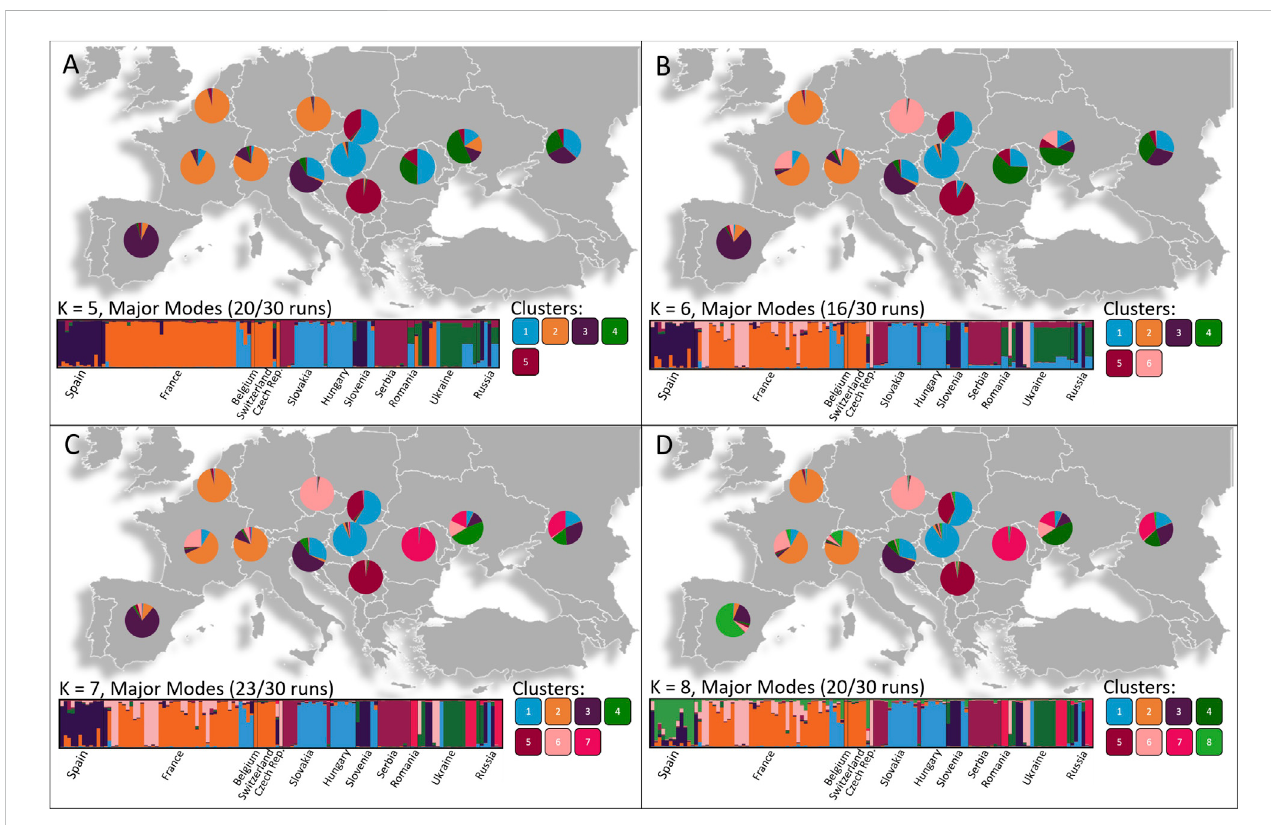
FIGURE 3 Geographical patterns of population divisions observed using STRUCTURE analyses based on the most likely K values determined by the Puecemaille methods with (A) K = 5, (B) K = 6, (C) K = 7, (D) K = 8. The number of individuals belonging to each Cluster is represented as pie charts in each respective country. Four main geneticgroups arespreadthroughout Western,Central andEastern Europe withseveralsmaller scattered geneticgroups residing among the